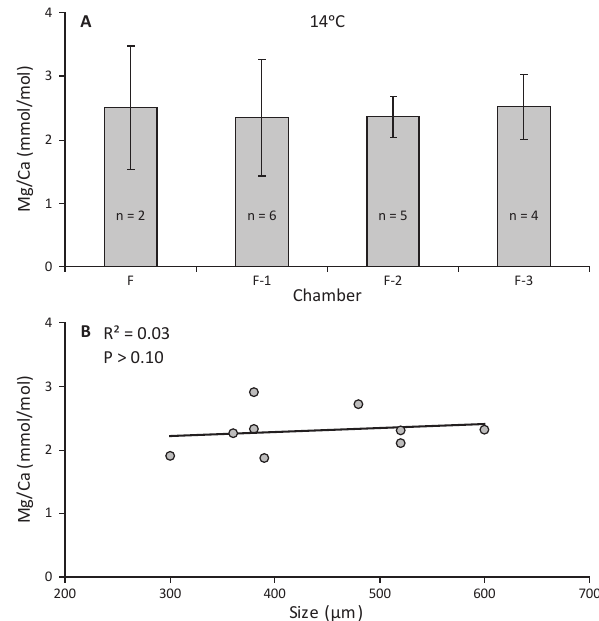
Fig. 3. Mg/Ca versus size for experiment 8 (14 ◦ C). The upper panel depicts the average Mg/Ca value per measured chamber and the number of individual chambers analyzed ( n ). The final chamber is indicated by F and counted down in the whorl afterwards (F-1, F-2, etc.) Measured Mg/Ca values are statistically not different from one another. The lower panel displays the average Mg/Ca values of in- dividual B. marginata born in the experiment versus their size. No trend can be observed between size and